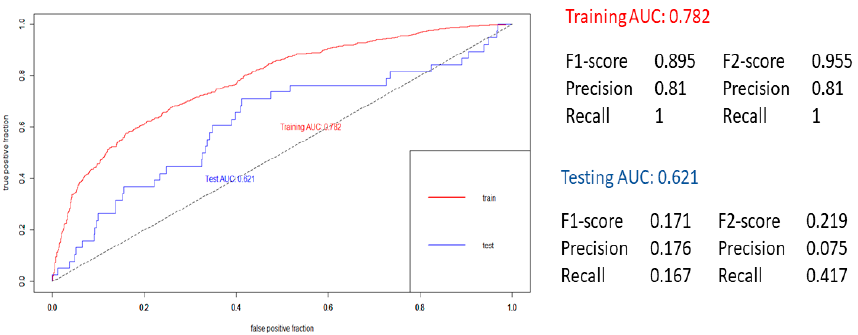
Figure 11. E11 regression coefficients.